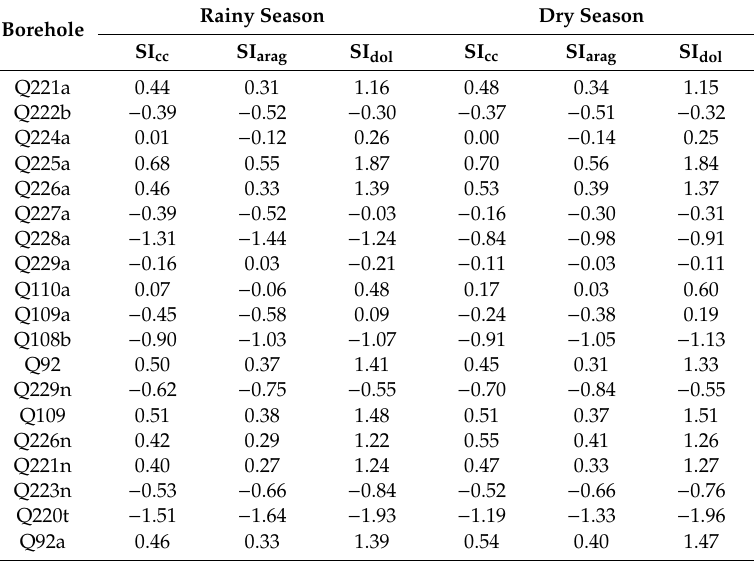
Table 4. Saturation indices (SI) of calcite, aragonite and dolomite in groundwater of Pleistocene, Neogene and Triassic in the study region.